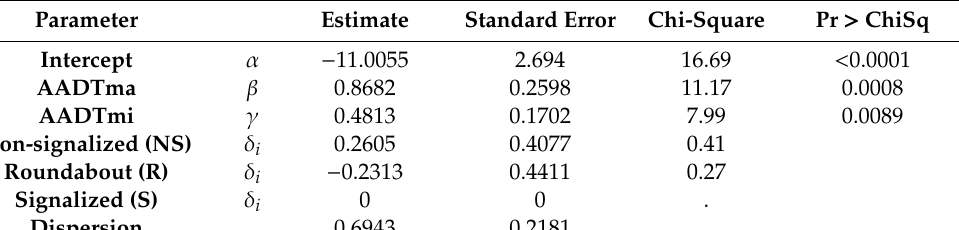
Figure 3. SPF diagram for segments in different road locations and road categories, with CCR equal to zero (tangent).